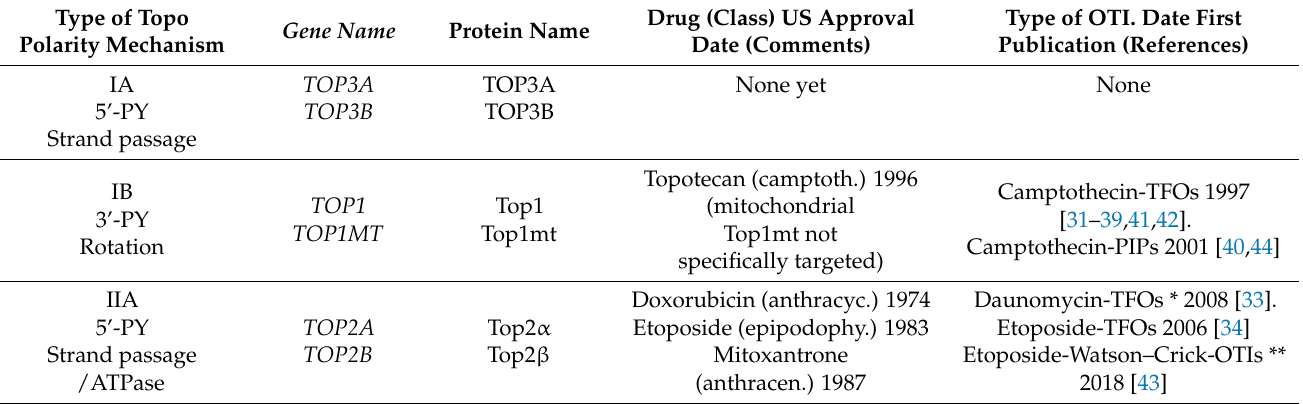
Table 1. Human topoisomerases, DNA-cleavage stabilizing anticancer drugs and derived